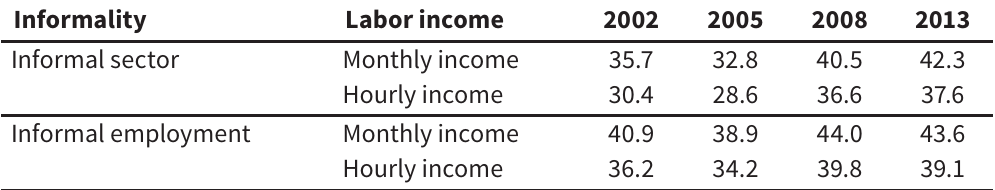
Average individual earnings gaps by informality type in Colombia, 2002–2013 Informality Labor income Informal sector Informal employment